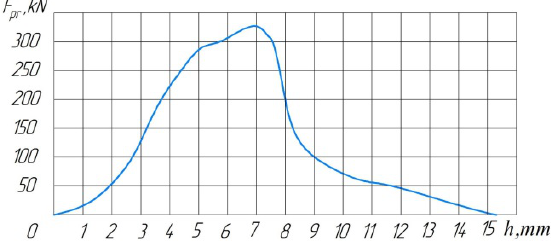
Figure 9. Force on the press slide vs. slide stroke during the cutting of rolled stock from 37Cr4 steel in a stamp with the differentiated clamp